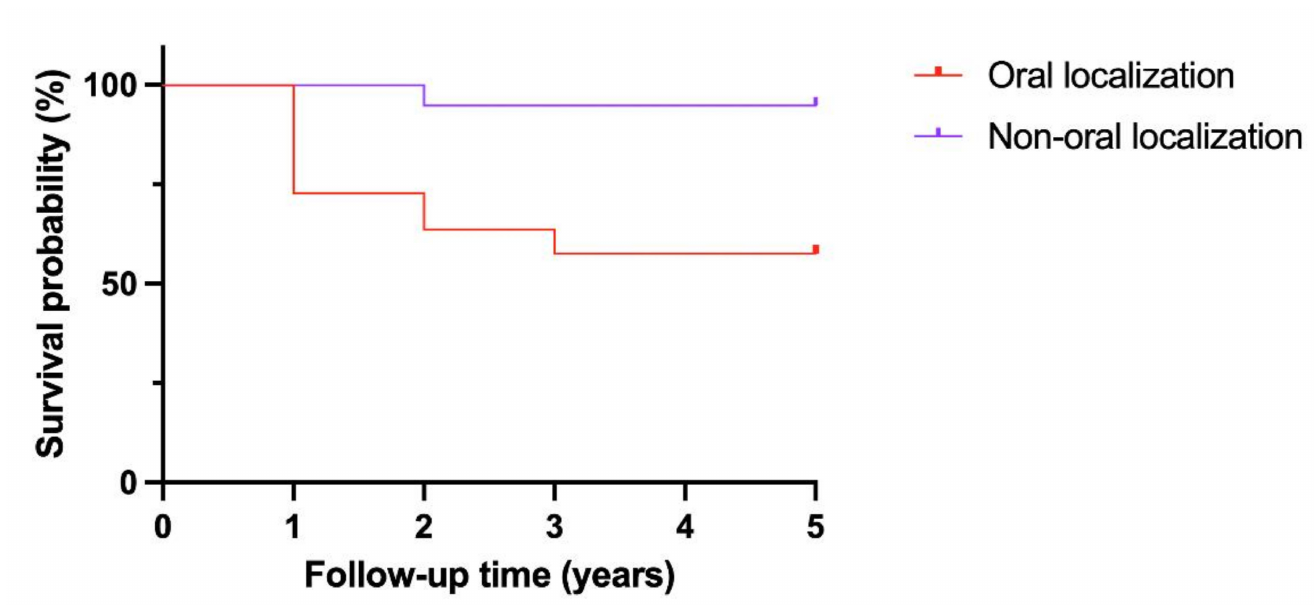
Figure 1. Kaplan–Meier